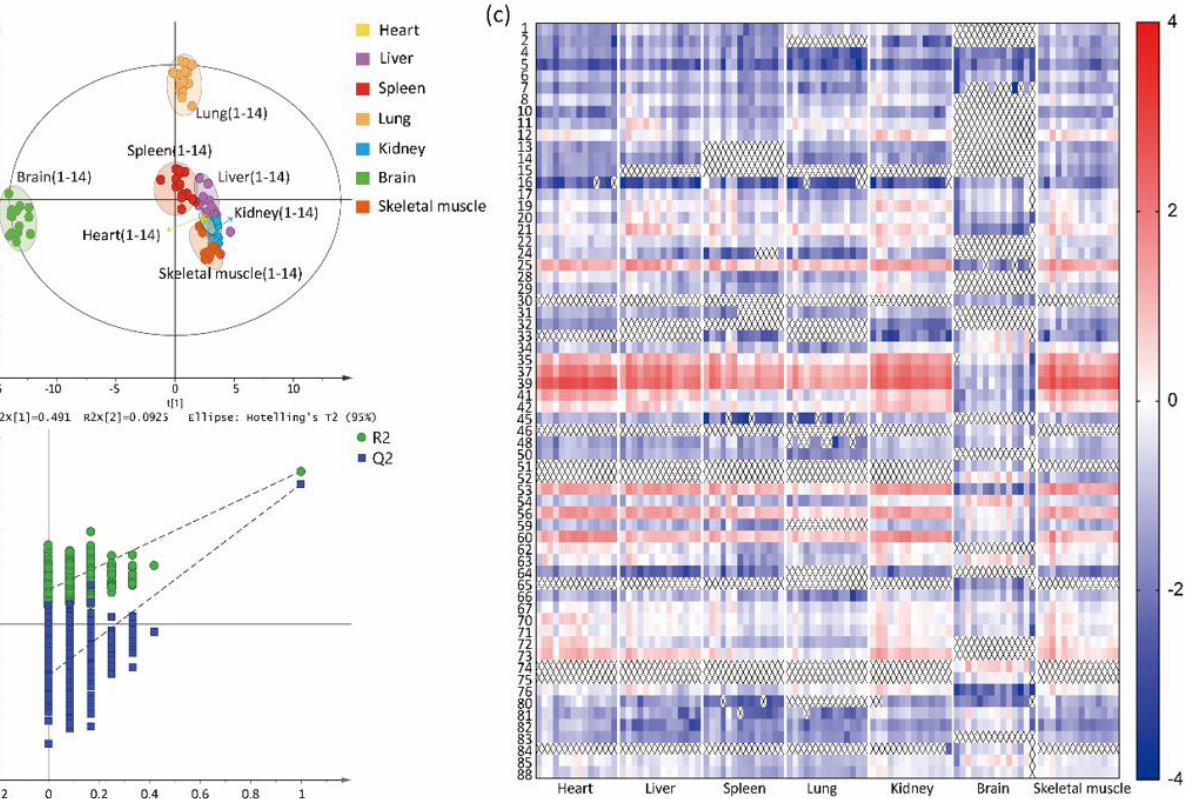
Figure 3. ( a ) OPLS-DA scores scatter plot of heart, liver, spleen, lung, kidney, brain, and skeletal muscle. ( b ) The 999 permutation tests for the OPLS-DA models based on seven tissues. ( c ) Changed multiple of the relative contents of 64 CLs, detected in seven tissues. Quantitation of CLs was performed by dividing the peak area of each CL by the peak area of CL (14:0) 4 . The value of each compound was the log 10 transformation of the relative content. The CLs not detected in the seven tissues were marked with